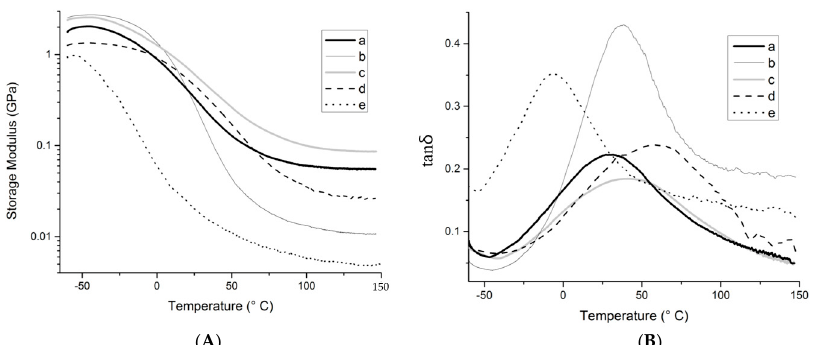
Figure 9. ( A ) Storage modulus (E’) vs. temperature and ( B ) tan δ curves for (a) a resin prepared with tung oil, (b) a resin prepared with fatty acids, (c) a composite prepared with tung oil, (d) a composite Table 2. DMA results for samples prepared with tung oil, tung oil fatty acids, and tung oil methyl esters. Major Resin Component